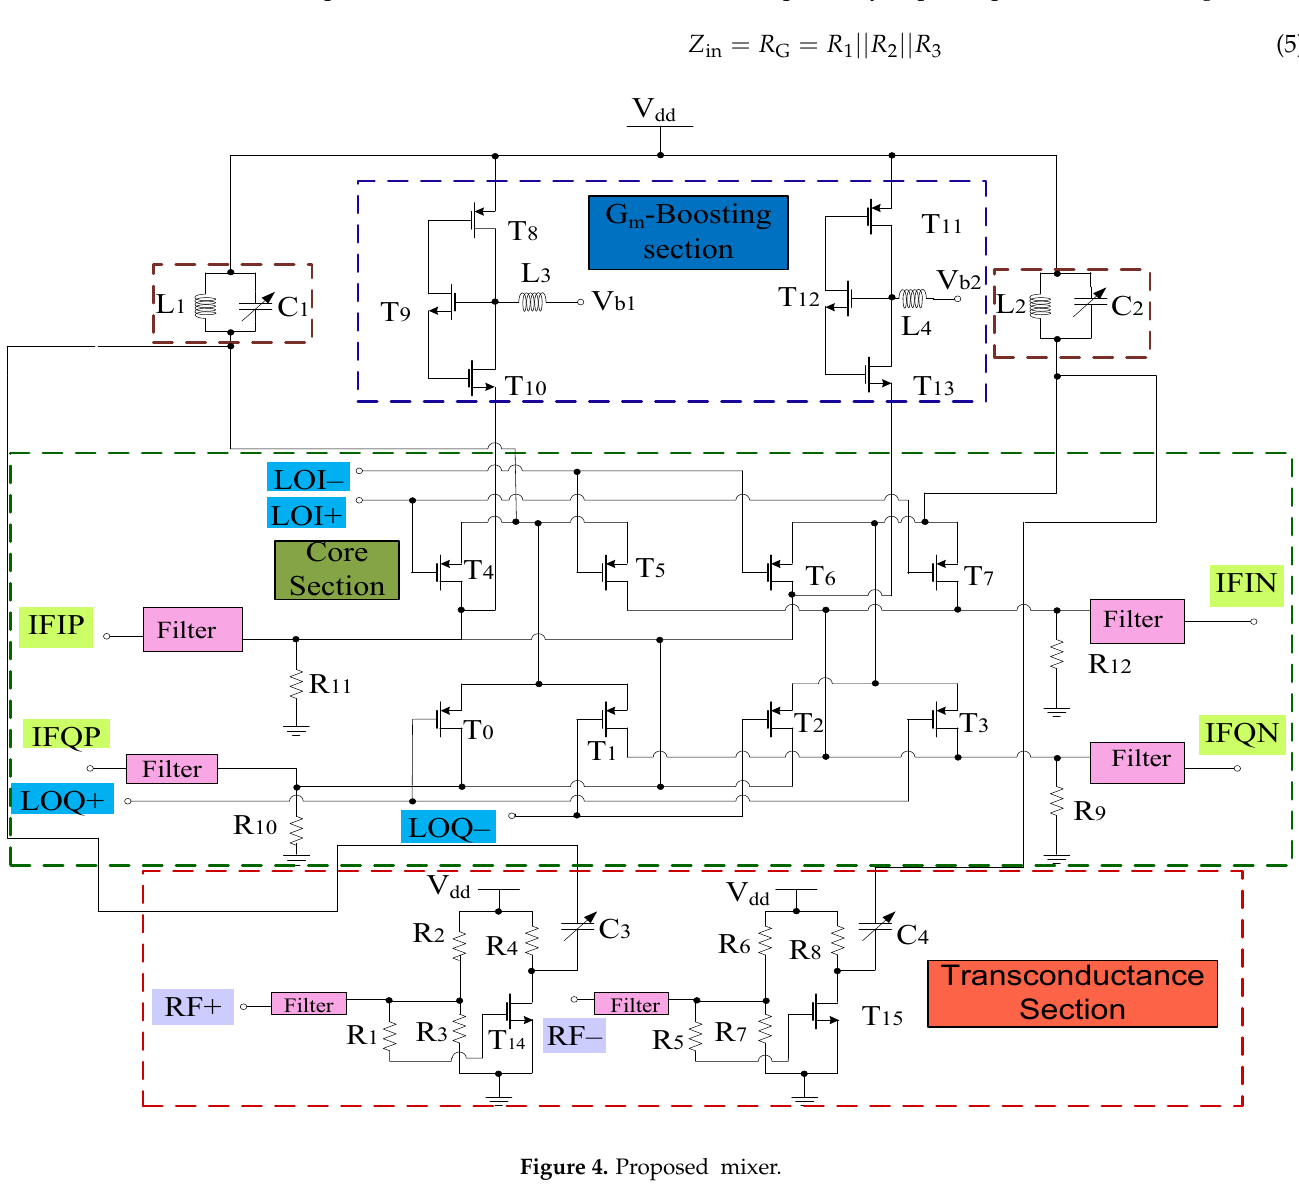
Figure 4. Proposed